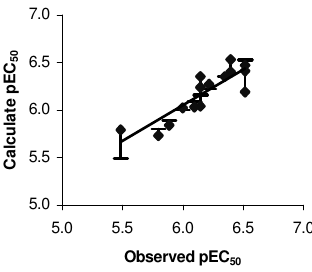
Figure 3. Plot between observed pEC